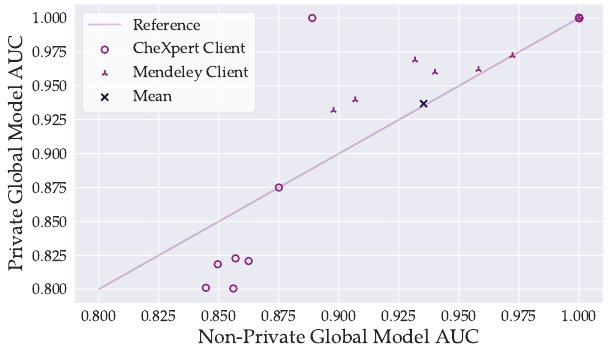
Figure 7. Comparison of per-client AUC values achieved by the best global DenseNet121 model between private ( ε = 6) and non-private training. The bottom left circle markers belong to CheXpert clients with large datasets. Privacy demanded a higher cost in model accuracy on CheXpert clients. The figure does not consider AUC values below 0.79. Markers may